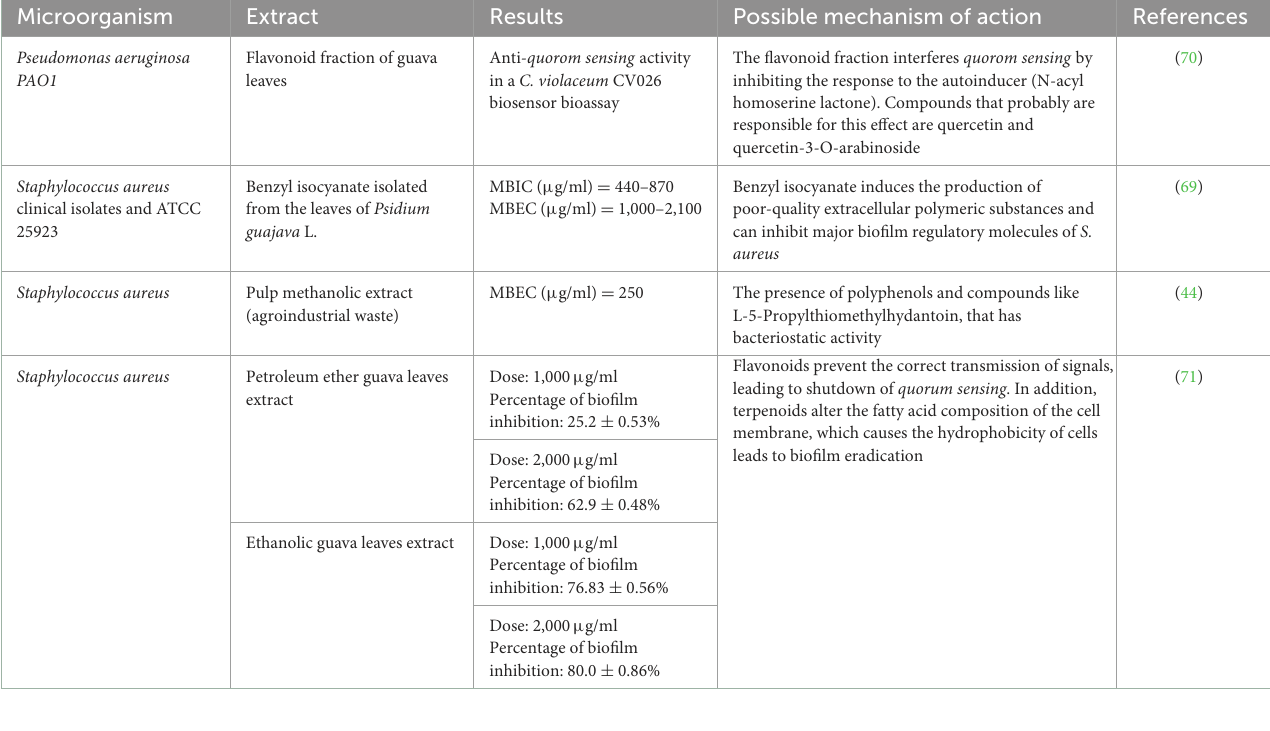
TABLE 4 Potential antibiofilm activity of different Psidium guajava L. extracts.